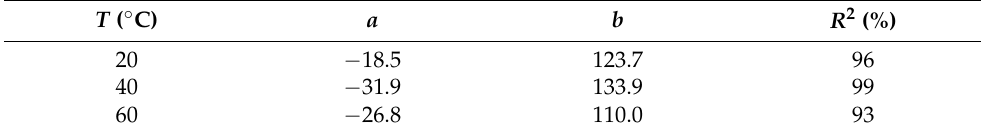
Table 3. Determined values of a and b